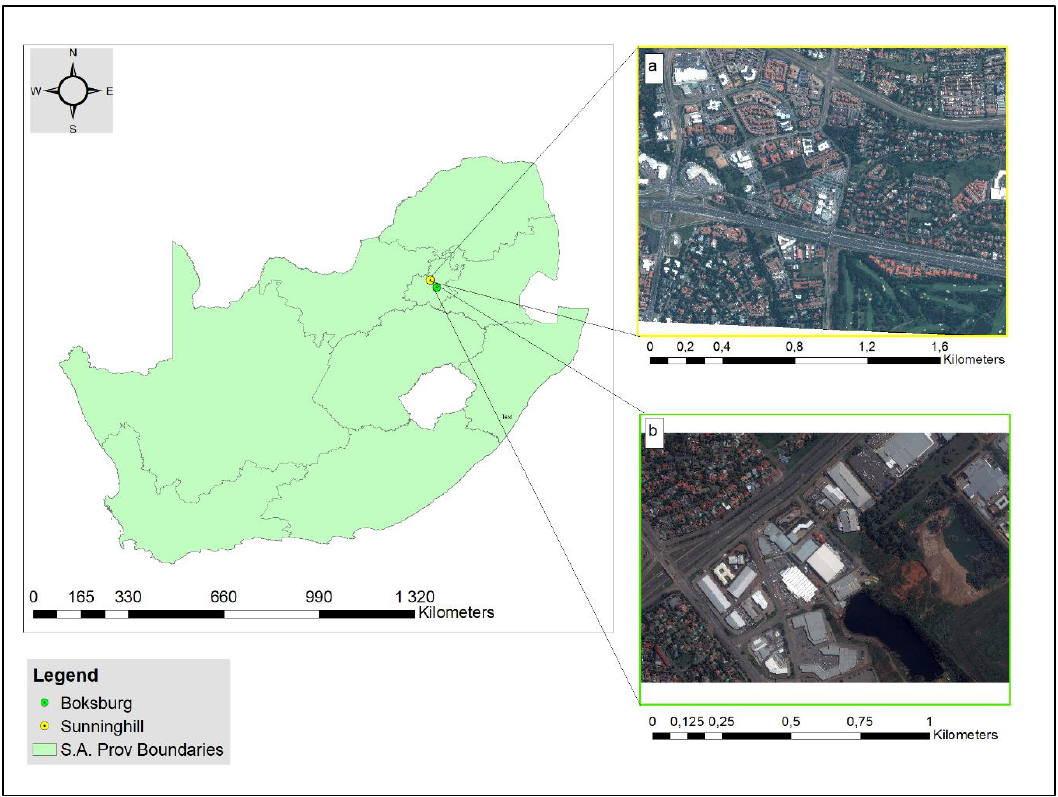
Figure 1. The study areas for the land-cover classification subset: (a) Sunninghill and (b) Boksburg.